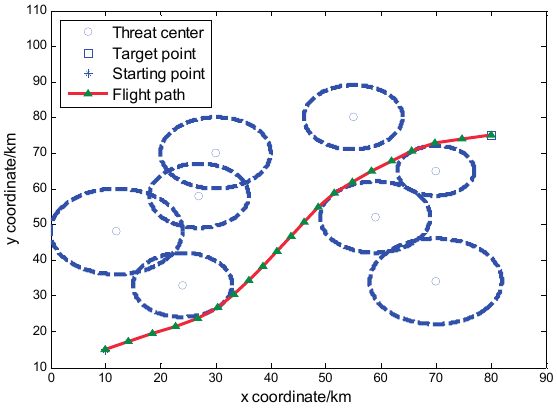
Figure 15. Result of the second instance for Maxgen = 150.